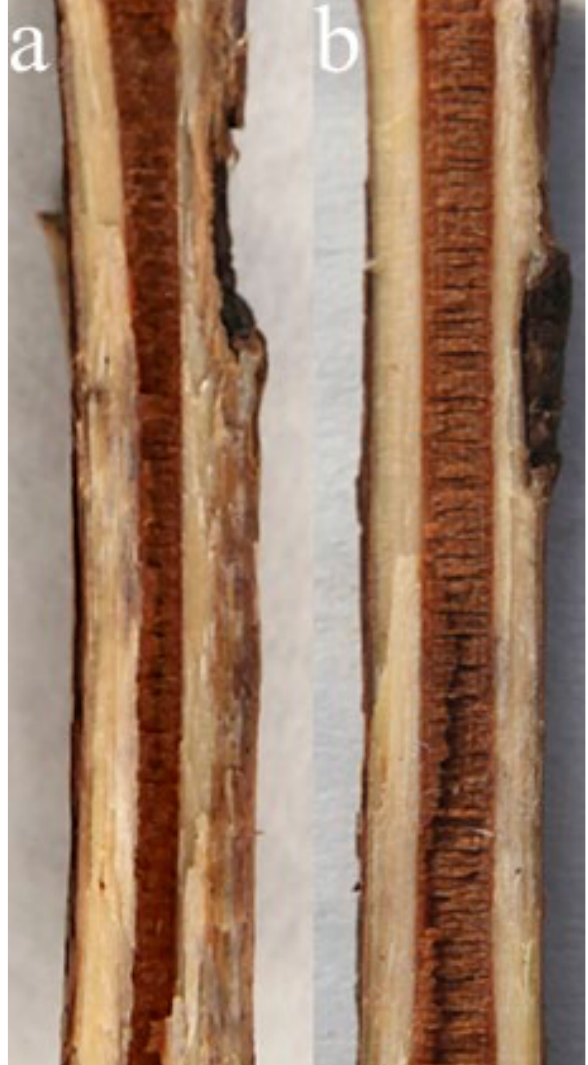
Figure 2. Vascular discolorations in longitudinal section on grapevine cv. Inzolia canes 6 months after inoculation with Neofusicoccum parvum. (a) and a control plant